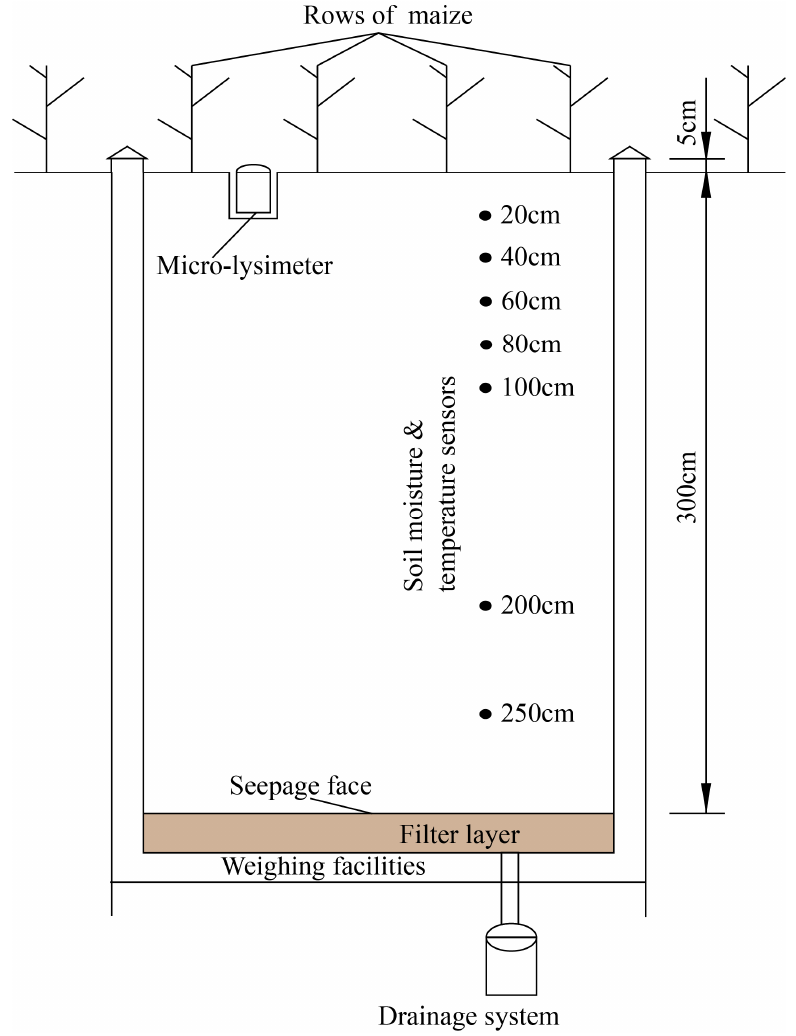
Figure 2. Drawing of the large lysimeter structure installed in the experimental fields.